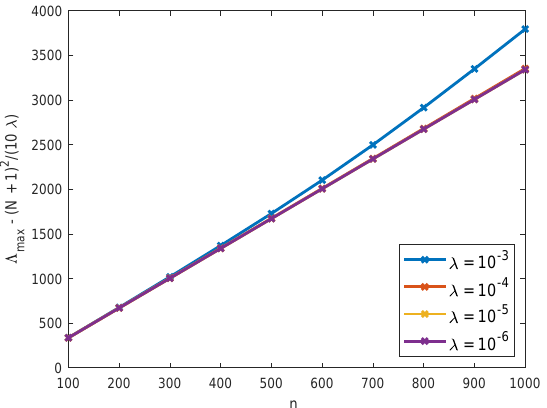
Figure 6. Fastest eigenvalue Λ max excluding the last part of the analytical formula (29) Λ max − ( N + 1 ) as λ decreases for different n x and constant N = 2. For the data, see Table